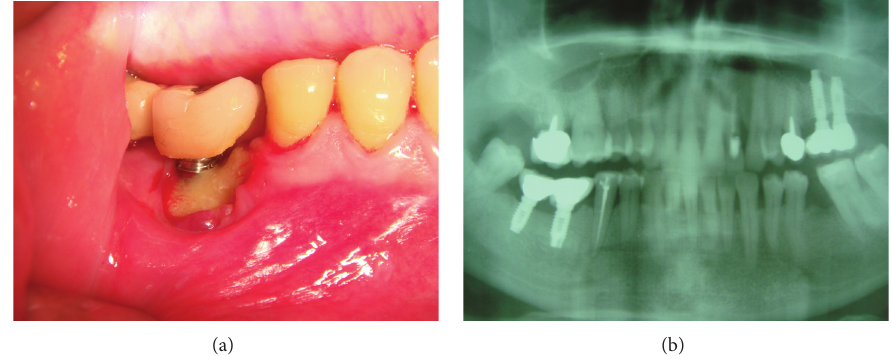
Figure 4: Clinical and radiological aspects of a peri-implantar Stage III BRONJ in a 55-year-old patient with breast cancer.